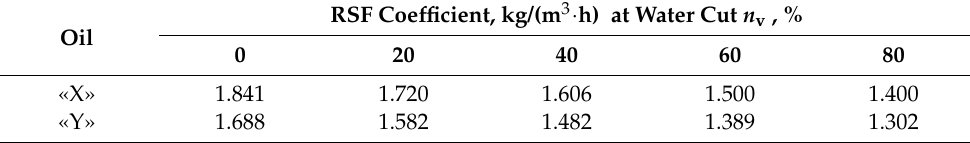
Table 4. RSF results of the laboratory